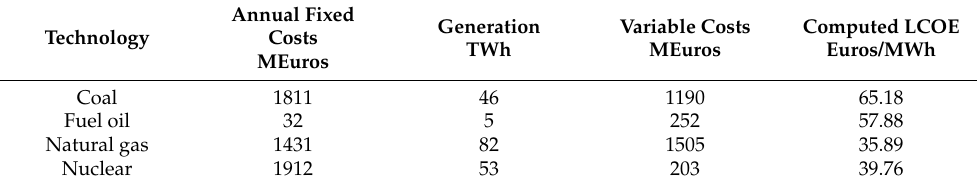
Table 3. Annual fixed and variable costs of the Iberian thermal technologies in 2018.